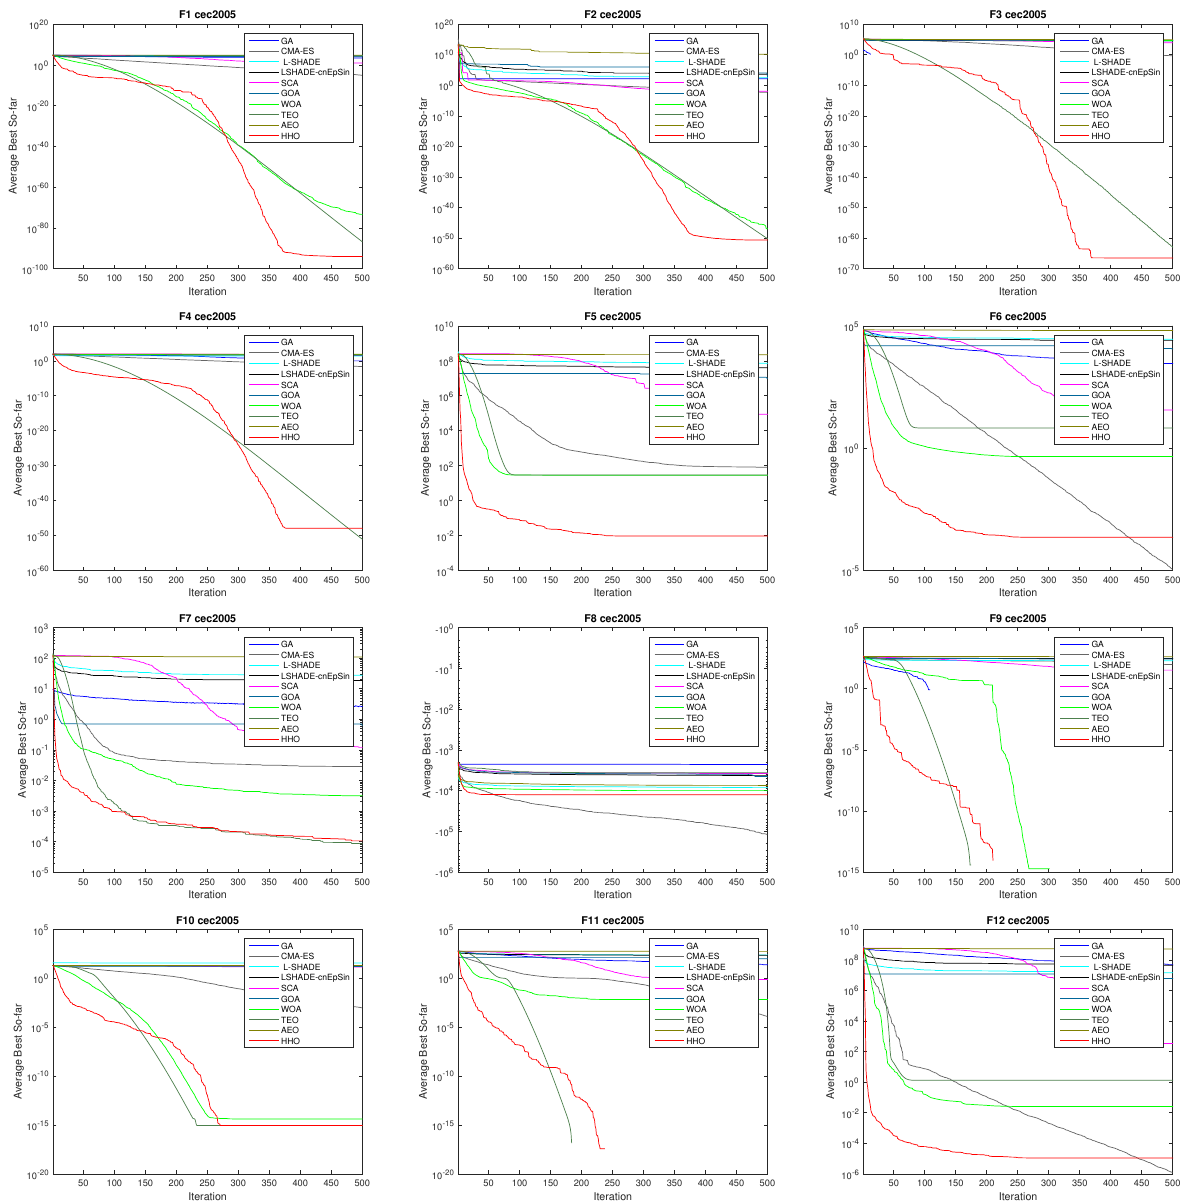
Figure 2. Convergence curve for HHO against other competitors from F1–F12